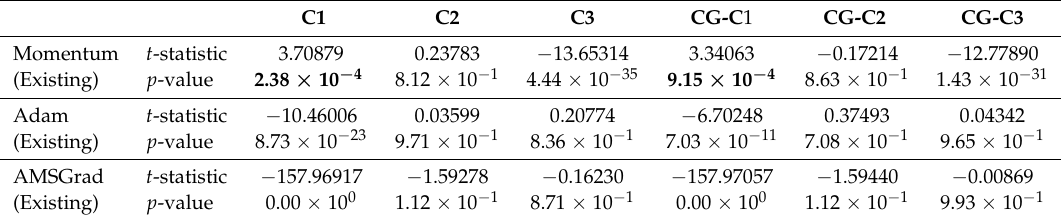
Table 2. Results of t -test on the training error rates of the existing algorithms (Momentum, Adam, and AMSGrad) and Algorithm 1 (C i and CG-C i ( i = 1,2,3)) on the CIFAR-10 dataset (significance level is 5%; the p -values for the proposed algorithms with significantly low error rates are indicated in